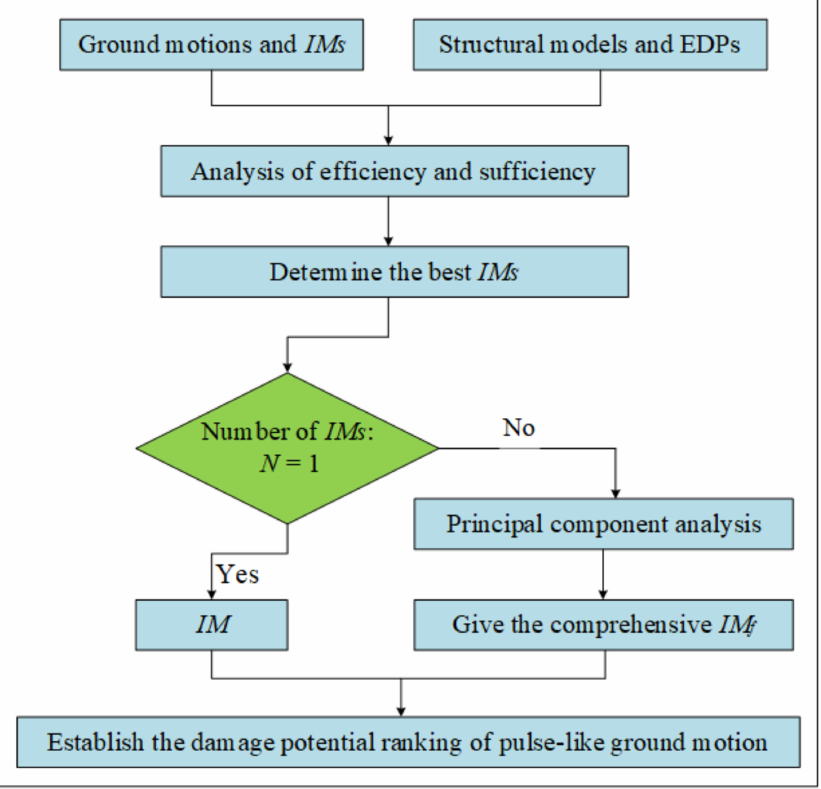
Figure 1. Technical